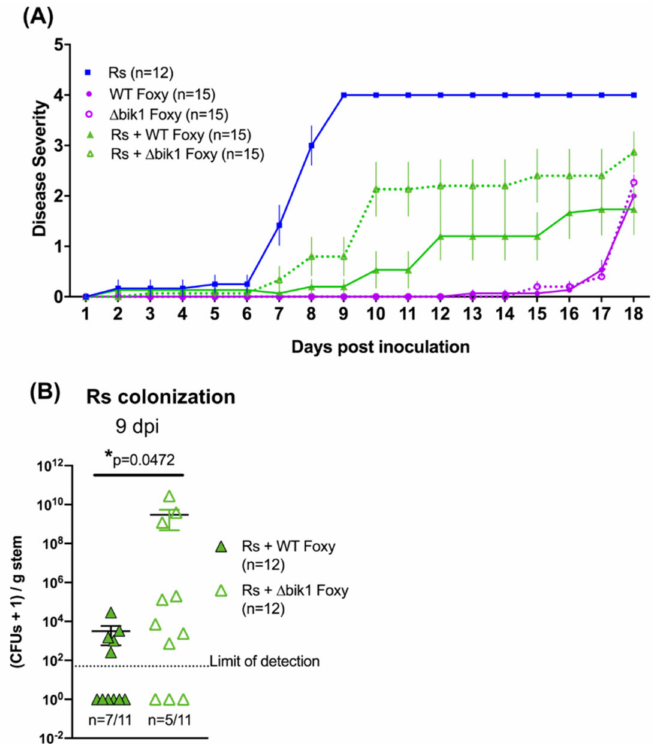
Figure 3. Bikaverin contributes to the reduction in bacterial wilt in co-infections. ( A ) Disease severity scores were assigned daily for 18 days. ‘ ∆ bik1 Foxy’ refers to the F. oxysporum strain whose backbone polyketide synthase gene ( bik1) required for bikaverin production was deleted. Two-way repeated- measures ANOVA was performed with time x treatment p = 0.0001. Tukey’s multiple comparisons showed significantly different disease between Rs + WT Foxy and Rs + ∆ bik1 Foxy ( p = 0.0002), Rs vs. Rs + WT Foxy ( p < 0.0001), and Rs vs. Rs + ∆ bik1 Foxy ( p < 0.0001). No significant difference in symptoms was observed between WT Foxy and ∆ bik1 Foxy ( p = 0.9994). ( B ) Bacterial CFUs recovered 9 dpi from shoots 1 cm above the cotyledons from plants co-infected with R. solanacearum and WT or ∆ bik1 F. oxysporum strains. CFUs are presented as CFUs+1 to take into account samples below detection limit, denoted nder each dataset. The data was non-normal. Mann–Whitney’s U test was performed with p =